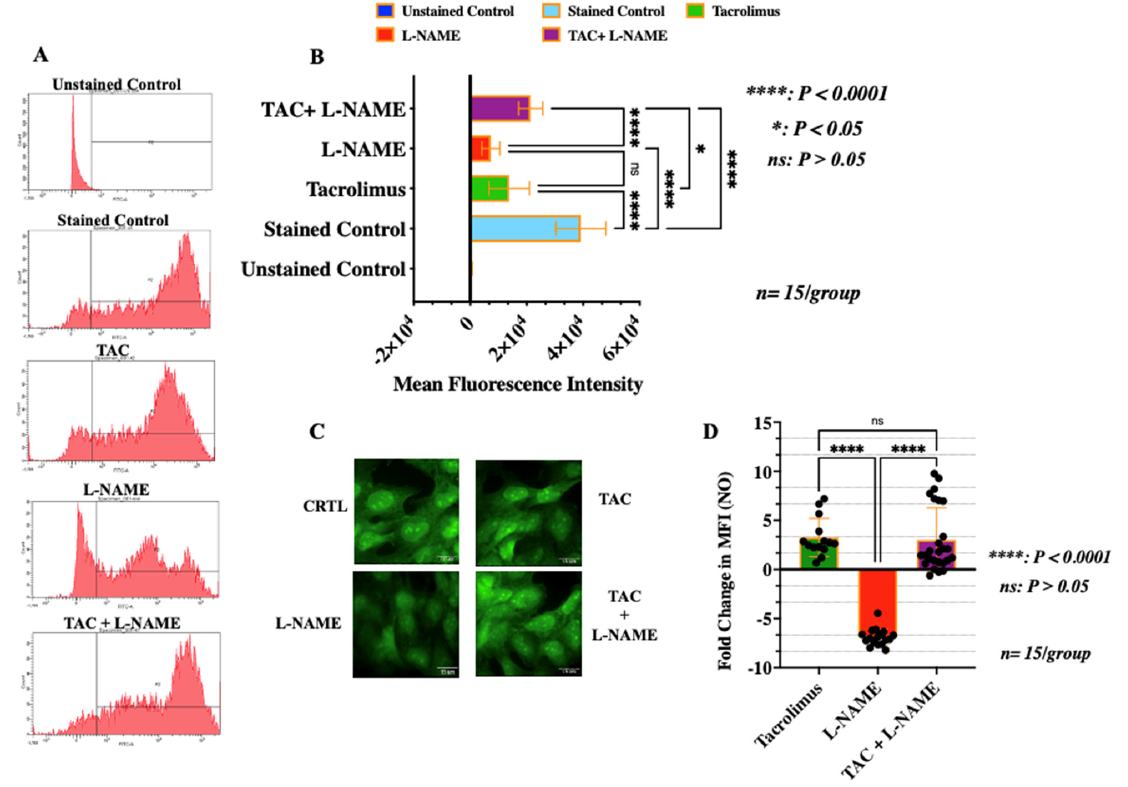
Figure 5. Effect of tacrolimus, L-NAME and combination treatment on NO production in HTR-8/SVneo cells. ( A ) Representative flow-cytometry histogram analysis of the NO levels